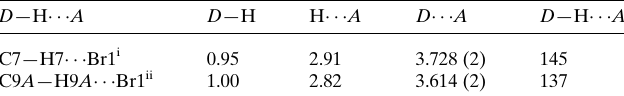
Table 2 Hydrogen-bond geometry (A˚ , (cid:2) ) for 2